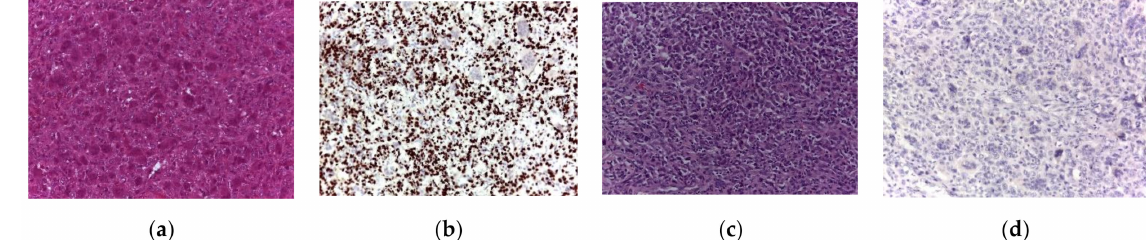
Figure 2. Histological specimens relative to secondary malignancy in giant cell tumor of bone. ( a , b ) Biopsy of the initial lesion, with the appearance of a giant cell tumor of bone (Hematoxylin and eosin [H&E], a , 200 × magnification) with strong immunohistochemical expression of the H3F3A protein G34W variant in mononuclear cells ( b , 200 × magnification). ( c , d ) Biopsy of the recurrent lesion. Highly malignant cells with a giant cell component and focal osteoid production were present (H&E, c , 200 × magnification). The spindled and pleomorphic neoplastic cells were negative for the H3F3A protein G34W variant ( d , 200 × magnification).